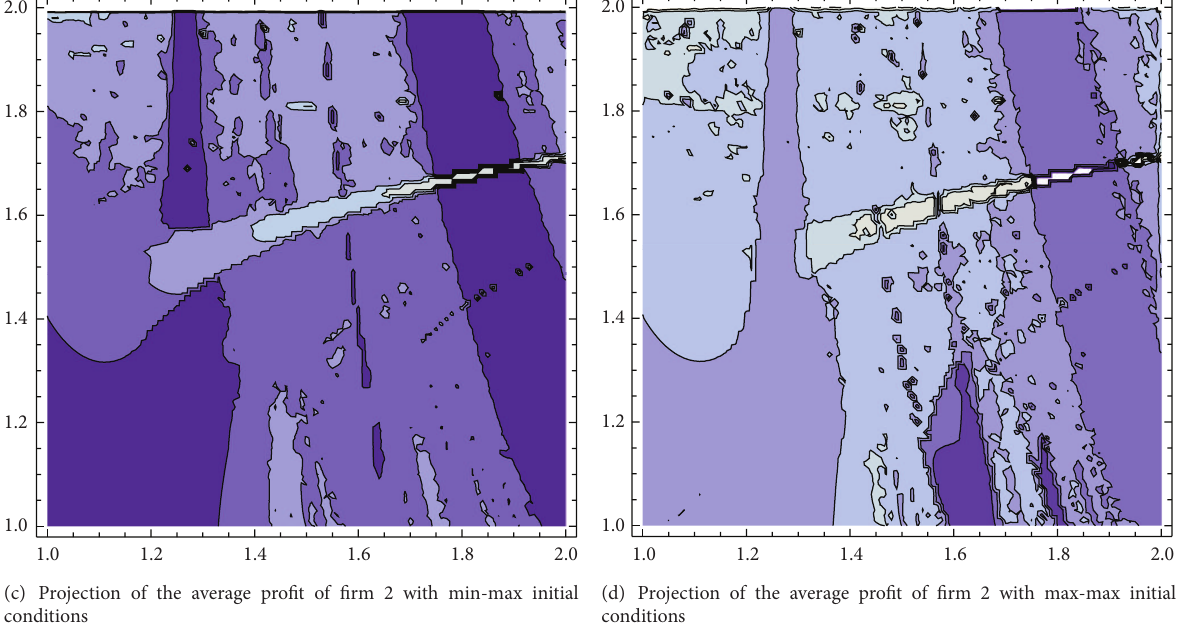
Figure 17: Average profit for firm 2 with different initial conditions. Note that in projections, the darker the color is, the lower the average profit